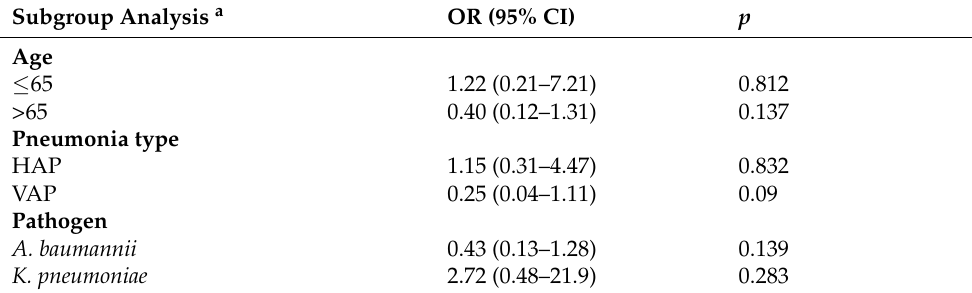
Table 3. Subgroup analysis of the primary outcome in patients with nosocomial pneumonia caused by carbapenem-resistant A. baumannii or K. pneumoniae